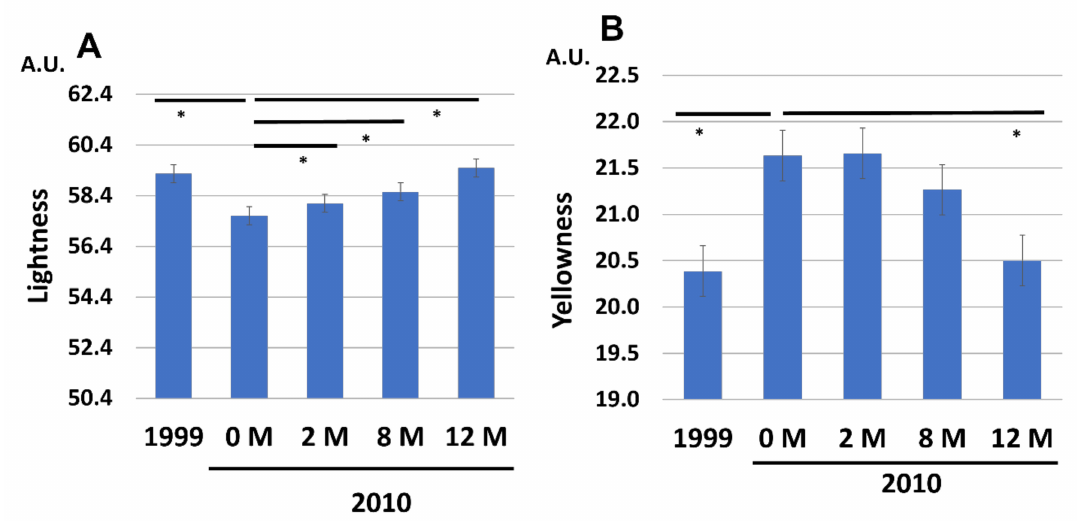
Figure 12. Chronological facial skin measurements in 1999 and in 2010 (at 0, 2, 8, and 12 M). All 86 subjects were treated with twice-daily application of G3 products for 12 M (0 M to 12 M). ( A ) Skin lightness. ( B ) Skin yellowness. * p <